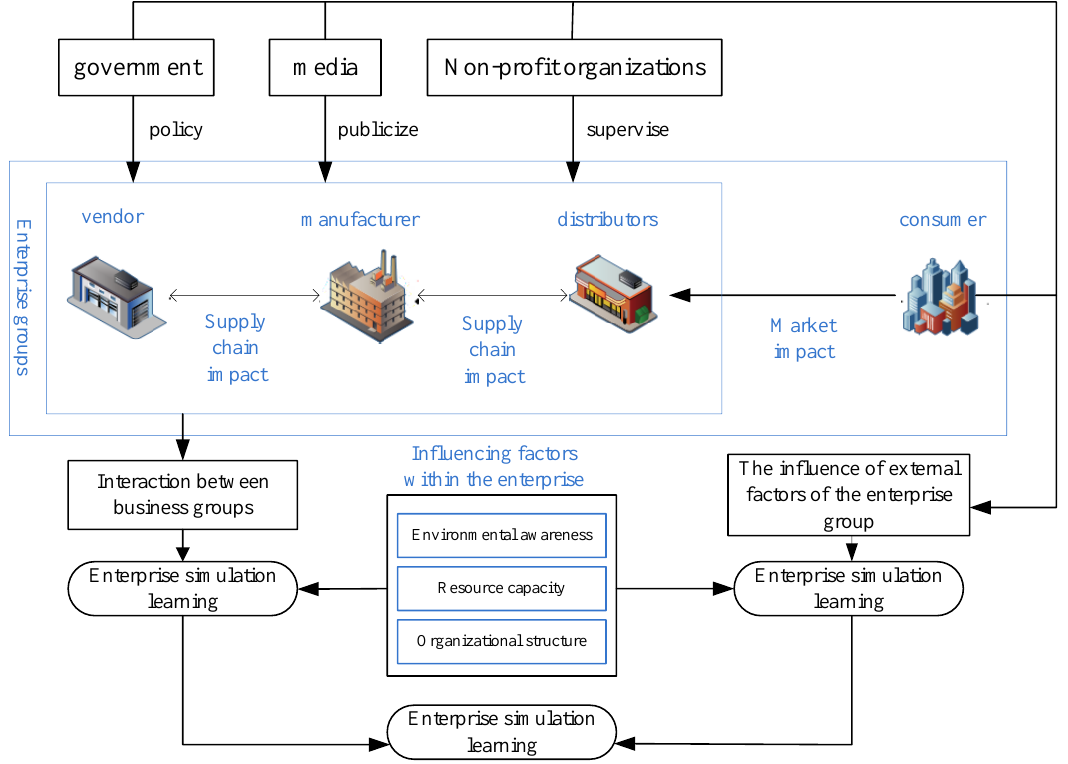
Figure 4. Factors affecting the diffusion of green supply-chain management.